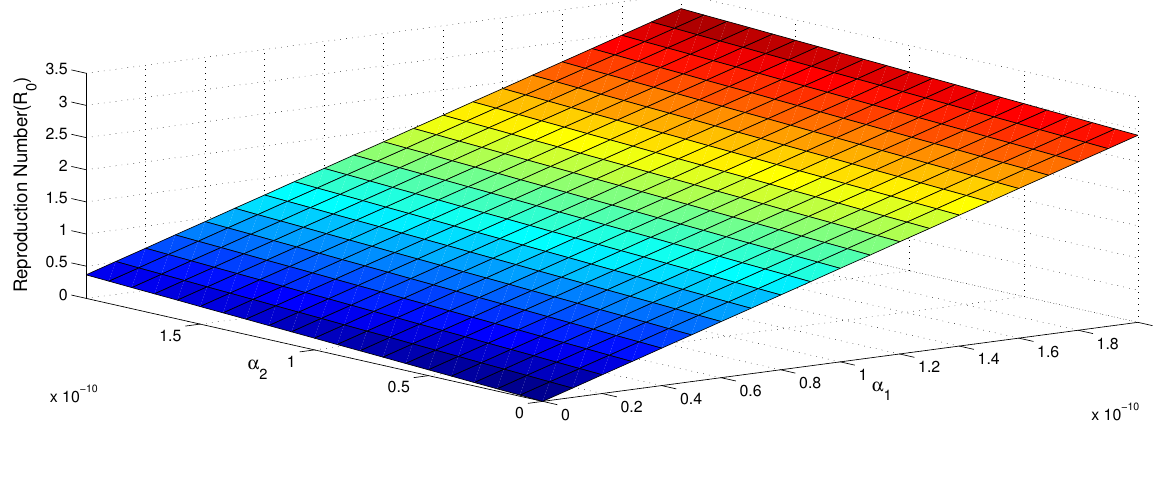
Fig. 2. Sensitivity of R 0 to α 1 and α 2 , rest of the parameters are based on Table 1